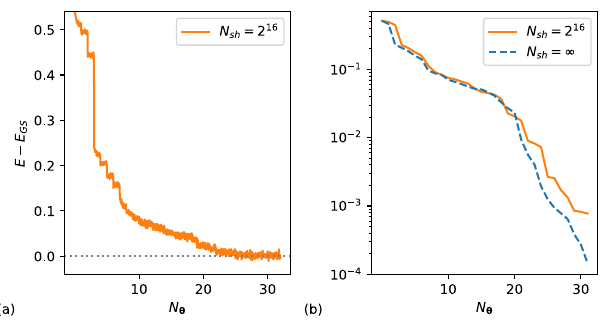
Fig. 9 Energy convergence of qubit adaptive derivative-assembled pseudo-trotter (ADAPT) noisy simulations of e g model with Adadelta optimizer. The difference between the exact ground state energy E GS and qubit-ADAPT noisy simulation results, obtained with number of shots N sh = 2 16 in panel ( a ). The energy differences evaluated using statevector for the adaptive ansätze obtained in the noisy simulations with N sh = 2 16 (orange line) are shown in panel ( b ). The statevector simulation results ( N sh = ∞ ) of the qubit-ADAPT method are also shown in a blue dashed line